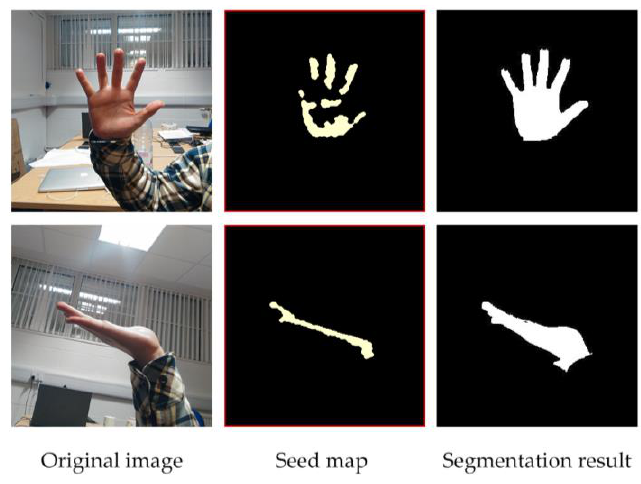
Figure 12. Segmentation results of our method on hand images.